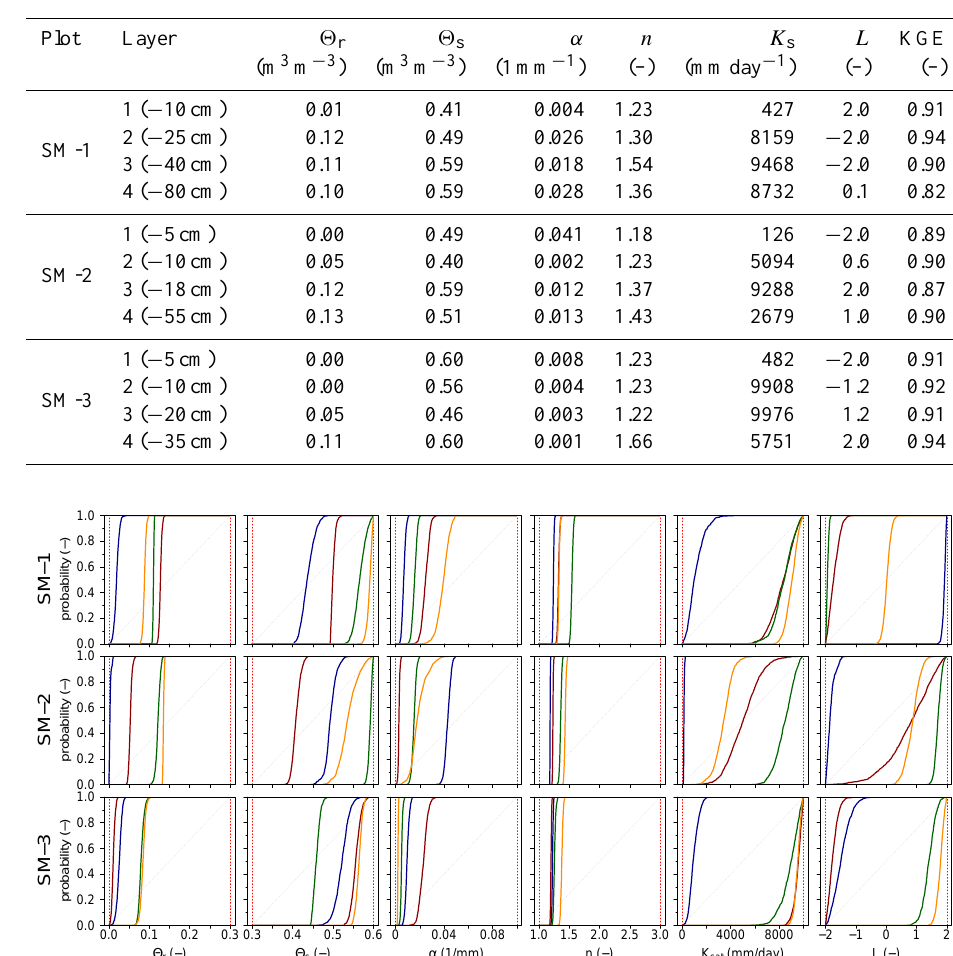
Table 3. SCEM-optimized hydraulic parameter sets for the different plots and probe depths.